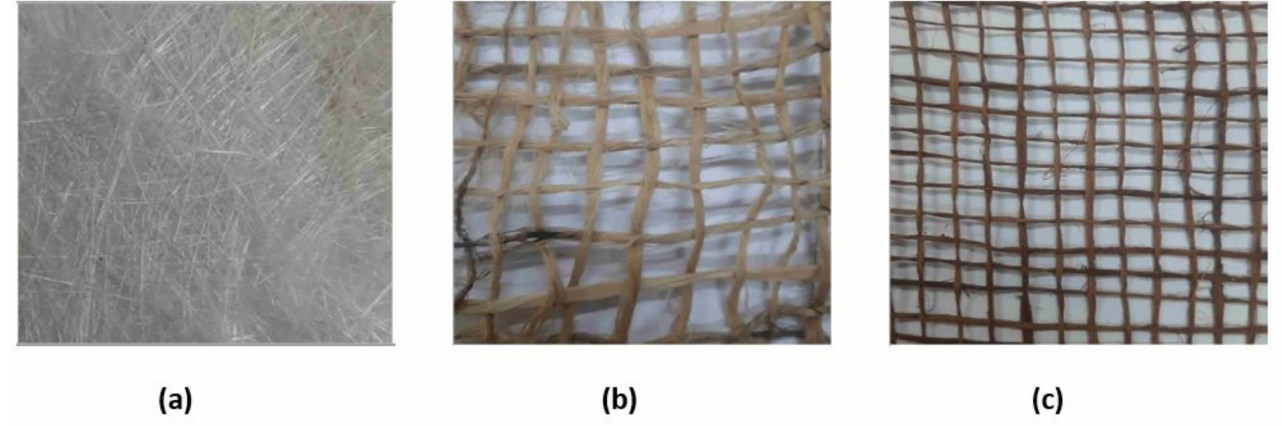
Figure 2. Showing ( a ) Glass fiber, ( b ) Jute fiber and ( c ) Grewia optiva